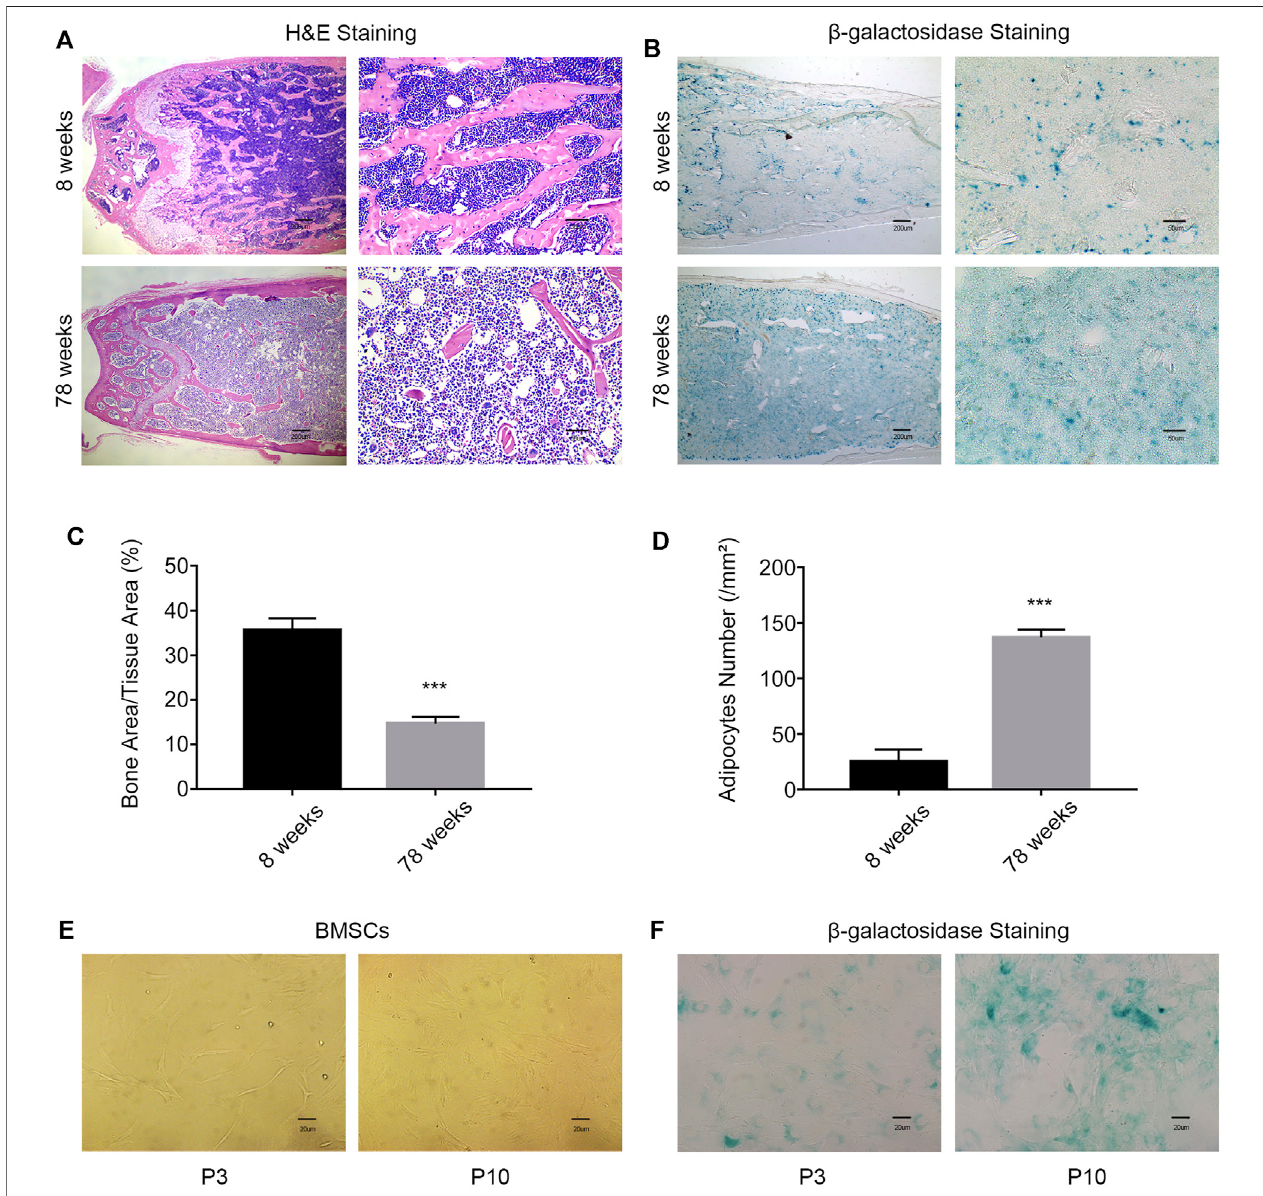
FIGURE1| With increasingage,theprobability ofage-relatedosteoporosisincreases. (A) Representativeimages ofH&Estainingofthefemurs of8-week-oldand 78-week-old WT mice. Scale bars, 200 and 50 µm. (B) β -Galactosidase staining of femur sections from 8-week-old and 78-week-old WT mice. Scale bars, 200 and 50 µm. (C) Percentage of the bone mass in femur sections from 8-week old and 78-week-old WT mice ( n = 3 and *** p < 0.001). (D) Enumeration of bone adipocytes in the femurs of 8-week-old and 78-week-old WT mice ( n = 3 and *** p < 0.001). (E) Morphology of MSCs was observed under an inverted microscope. Scale bar, 20 µm. (F) β -gal staining (blue: senescent cells) of MSCs was observed under an inverted microscope. Scale bar, 20 μ m. P3, early passage; P10, late